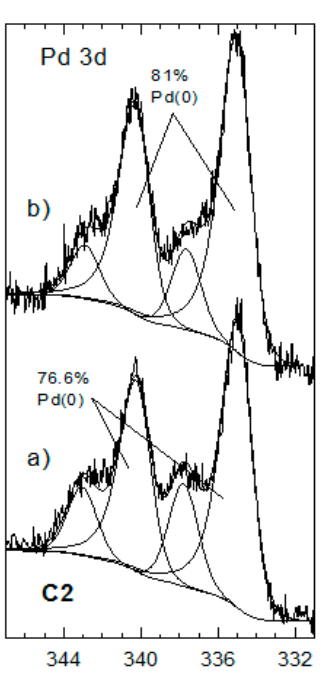
Figure 4. Pd 3d core level spectra for Pd/DNA (C2) recovered after the Suzuki–Miyaura reaction ‘as received’ form ( a ) and after smooth Ar + sputtering (500 eV, 1 min, 0.2 µ A/cm 2 + 1 keV, 1 min, 1.3 µ A/cm 2 ) ( b ).